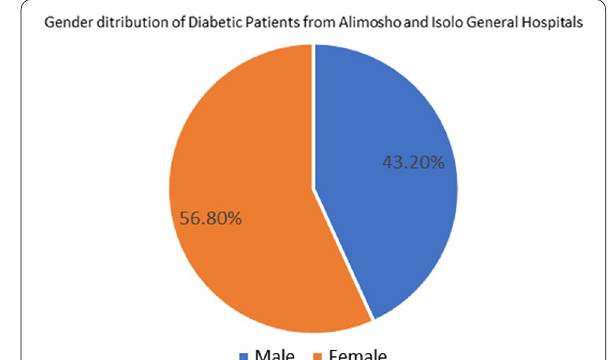
Fig. 3 Gender of diabetic patients in Alimosho and Isolo General